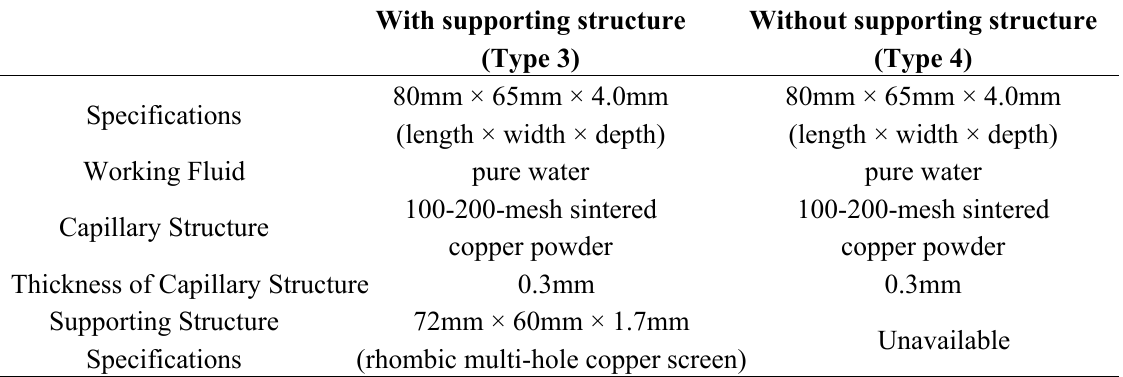
Table 2. The production parameters of the heat pipes using different capillary